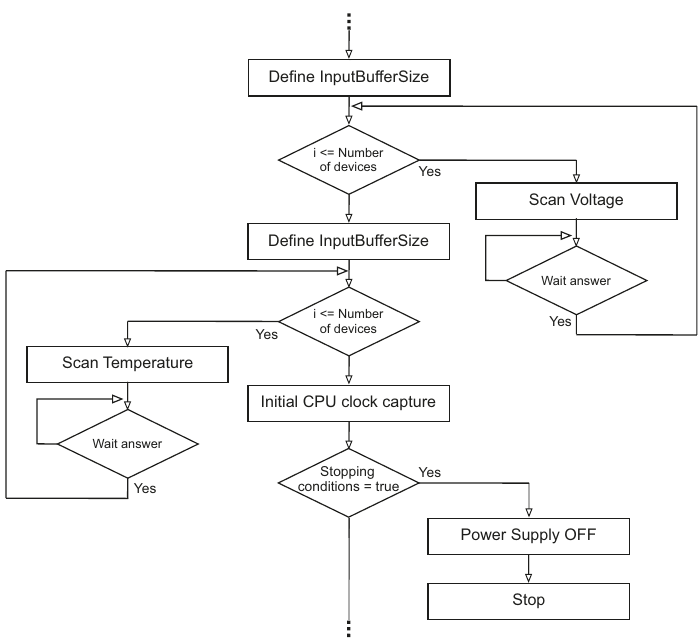
Figure 12. Flowchart of the program implemented in the main control unit—Second Segment.